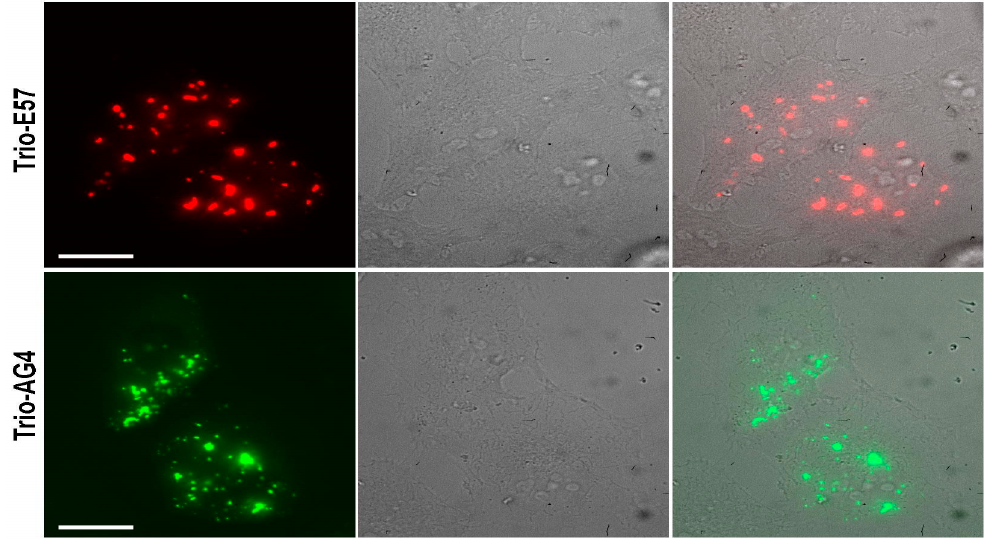
Figure 8. Aggregation of Trio-E57 (upper row) and Trio-AG4 (bottom row) in HeLa Kyoto cells. Left—fluorescence in red or green channels, middle—transmitted light, right—overlay. Scale bars, − 20 µm.